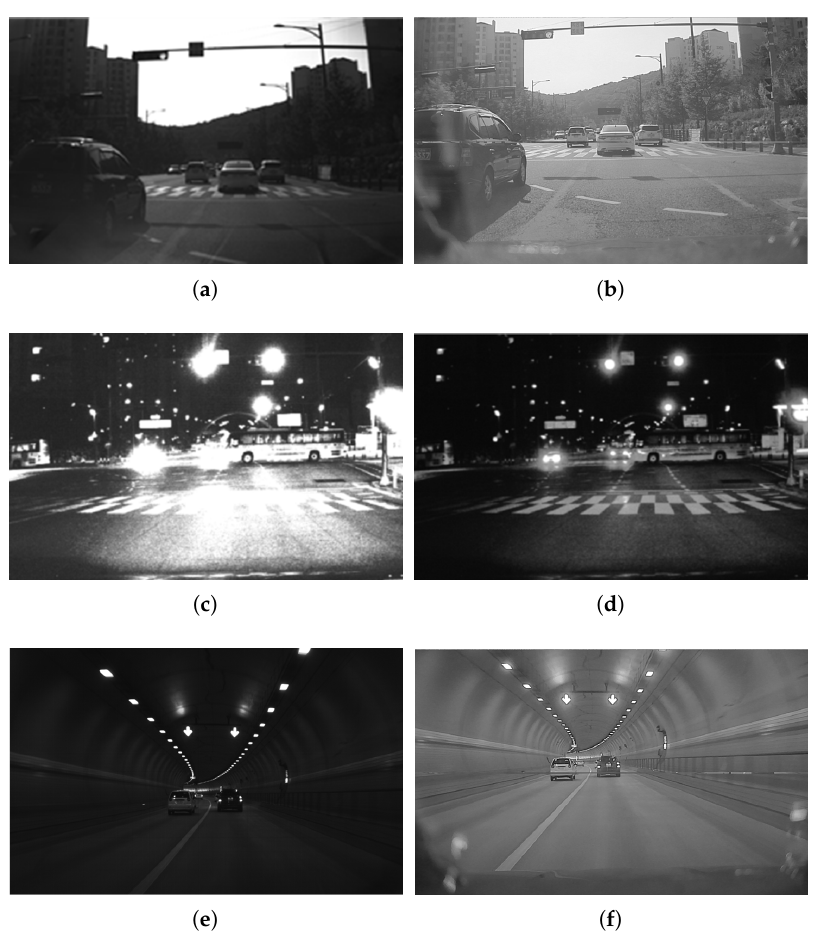
Figure 18. Test results for image quality enhancements: ( a ) backlight condition (without illumination data), ( b ) backlight condition (with illumination data), ( c ) night driving situation (without illumina- tion data), ( d ) night driving situation (with illumination data) ( e ) entering tunnel situation (without illumination data), and ( f ) entering tunnel situation (with illumination